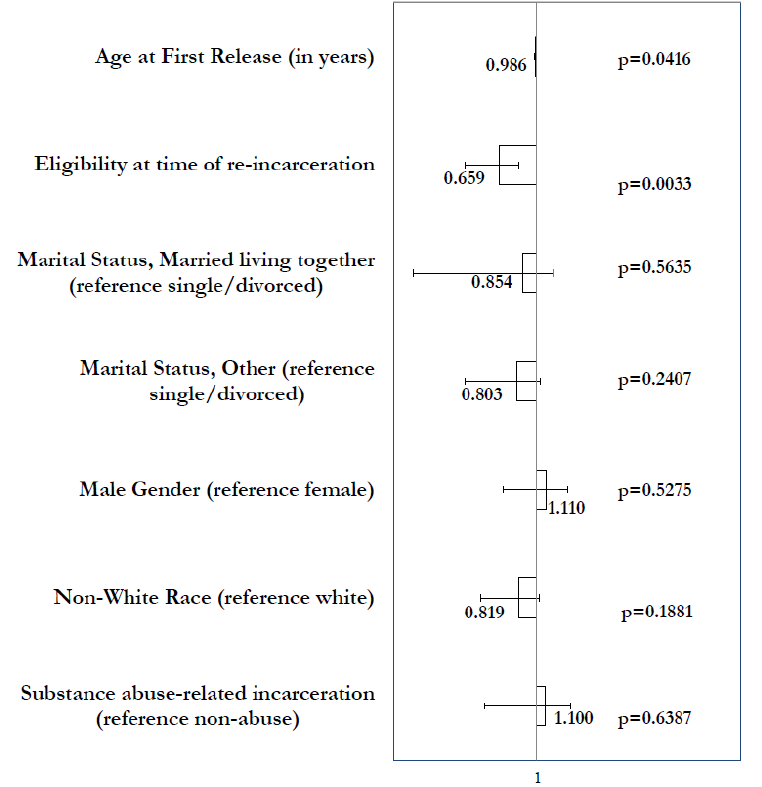
Figure 2. Three-year Survival Analysis Hazard Ratios and 95% Confidence Intervals for Eligibility at Re-incarceration (Eligibility Measure 1)